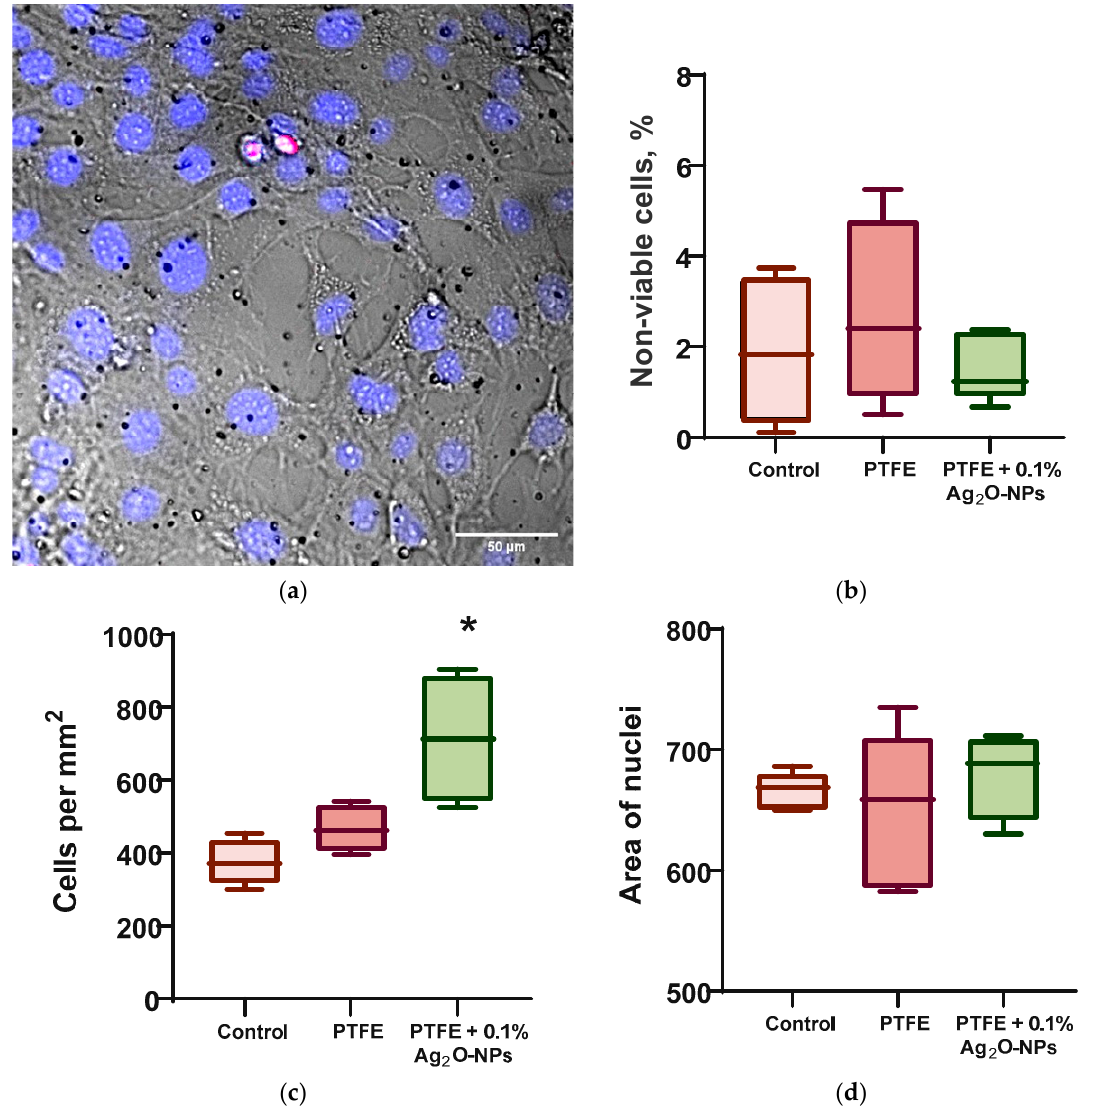
Figure 9. Influence of composite coating fluoroplast/Ag 2 O NPs on the growth of mouse fibroblasts in vitro after 72 h of cultivation. ( a ) An example of a photomicrograph of cells growing on the surface of a composite coating of fluoroplast/NP Ag 2 O 0.1% (merge: blue-Hoechst, red-PI, transmitted light-gray). ( b ) proportion of non-viable cells. ( c ) Density of cell cultures. ( d ) Mean nuclear area. *: statistically significant difference compared to the “Control” group ( p < 0.05). Data are presented as mean ± standard error of the mean.